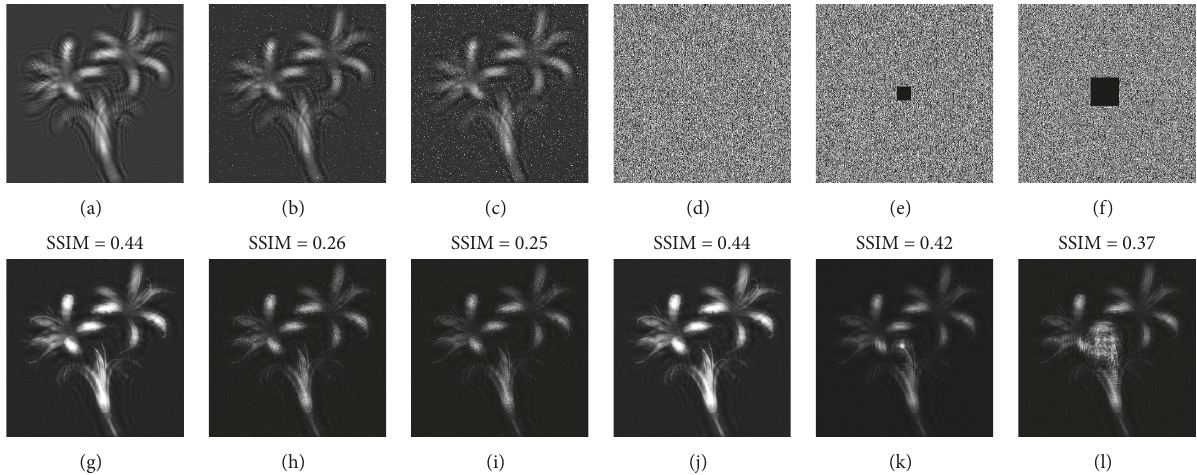
Figure 6: Test of robustness against noise attack and occlusion: (a) hologram without noise, (b) 1% Salt and Pepper noise on hologram, (c) 1.5% Salt and Pepper noise on hologram, (d) encrypted image, (e) 0.6% data loss on (d), and (f) 2.44% data loss on (d). The second row shows their corresponding decrypted images.